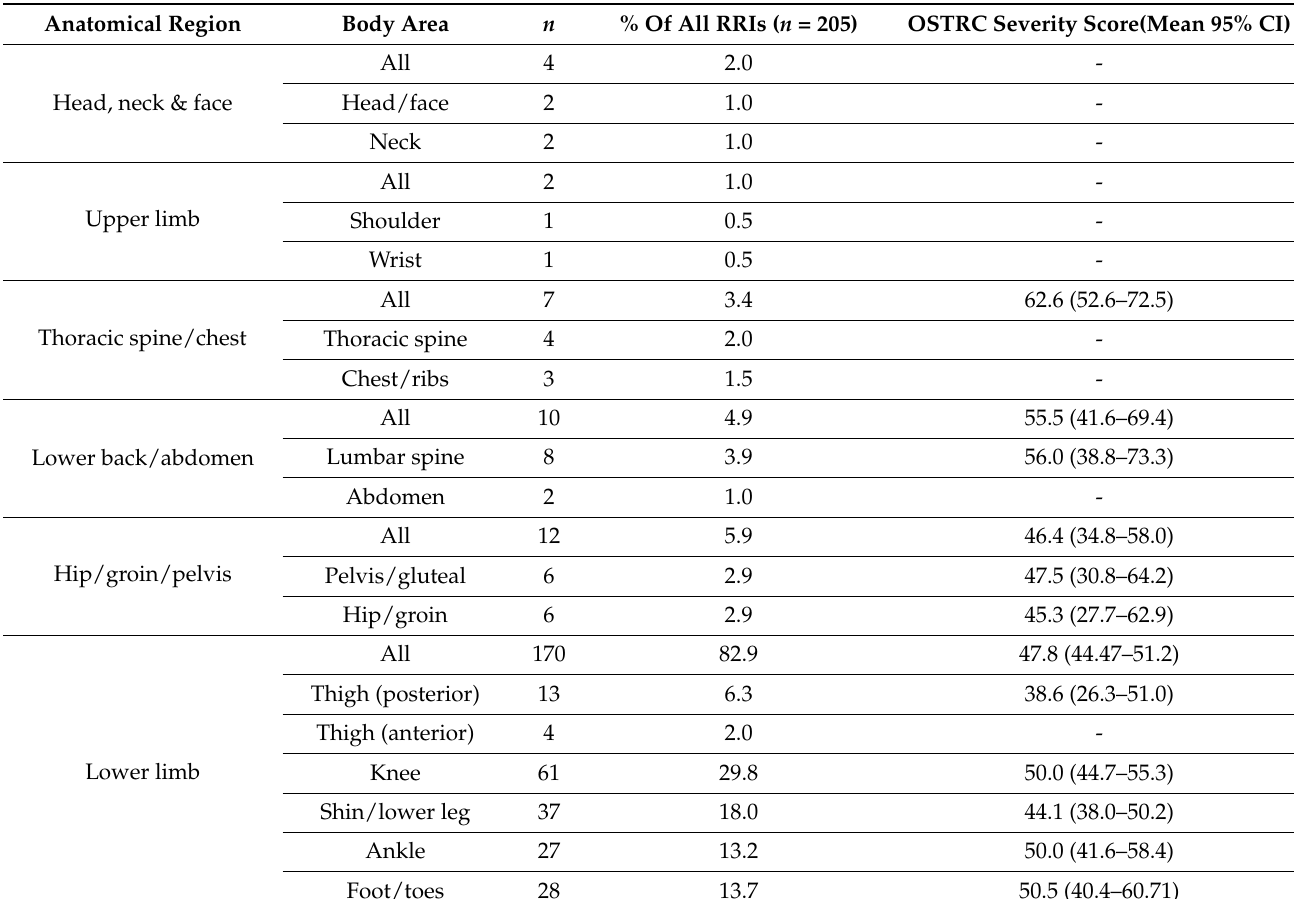
Table 4. Anatomical region and specific body area of all RRIs ( n = 205) among 152 trail runners (% all RRIs and OSTRC injury severity